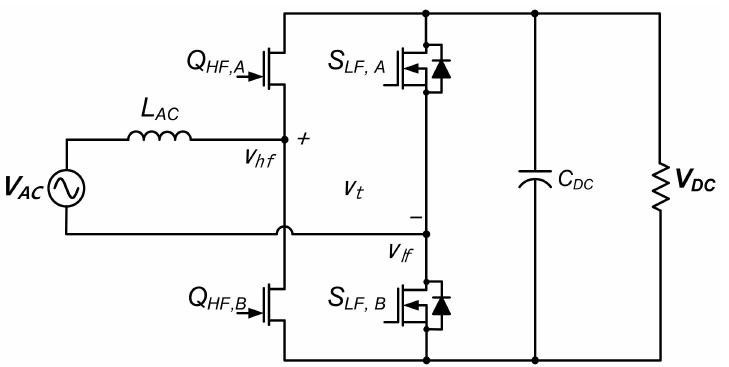
Figure 1. Circuit of totem-pole bridgeless power factor correction